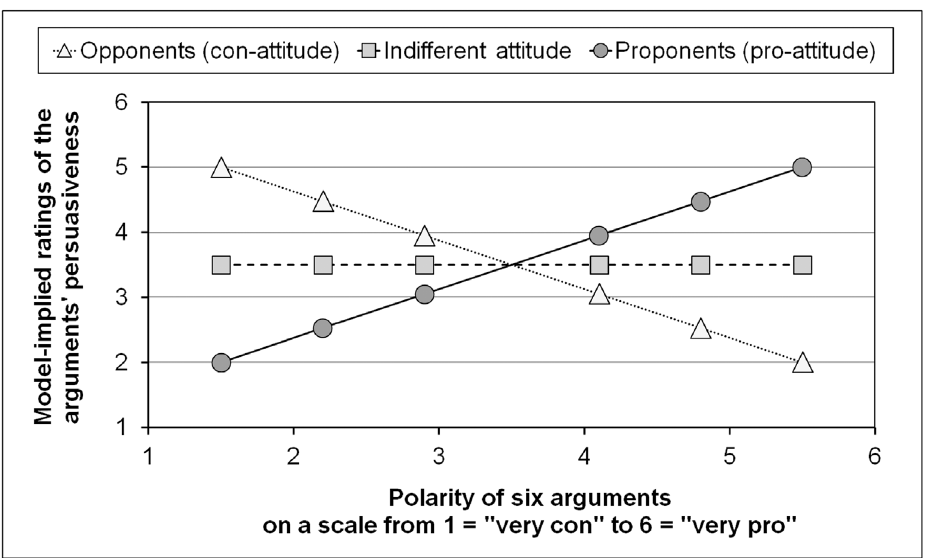
Fig 2. Hypothetical persuasiveness ratings if the continuous metric of arguments ’ polarity is taken into account.